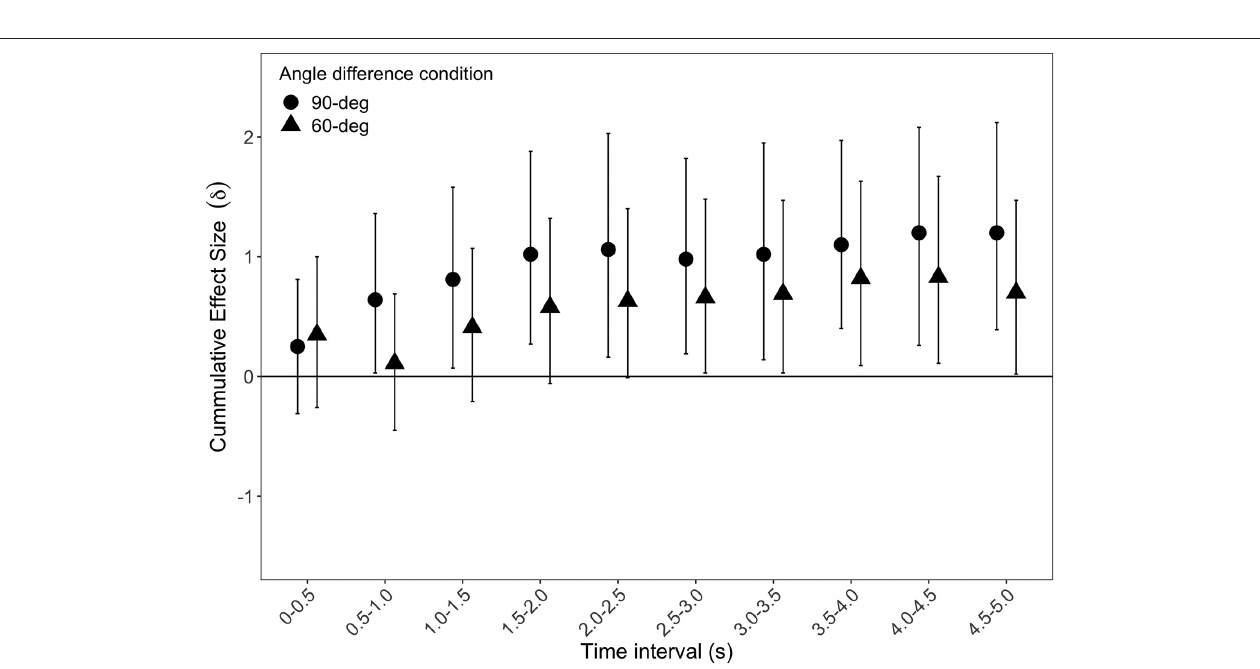
FIGURE 3 | Median cumulative effect size as a function of time interval for the 60- and 90 ◦ conditions. Vertical bars denote 95% confidence intervals of the effect